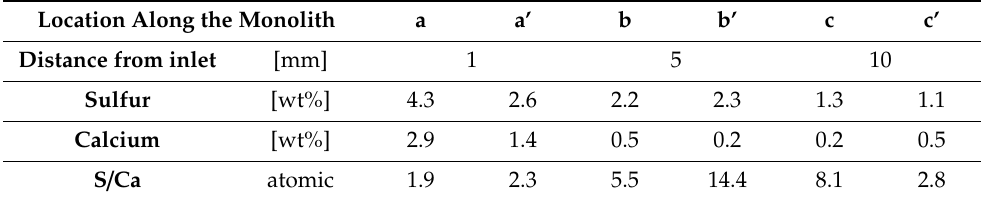
Table 3. EDS elemental analysis of the surface concentration of sulfur and calcium at different locations along the channel of the reaction-aged SCR catalytic honeycomb (distance from inlet: a, a’ = 1 mm; b, b’ = 5 mm; c, c’ = 10 mm).